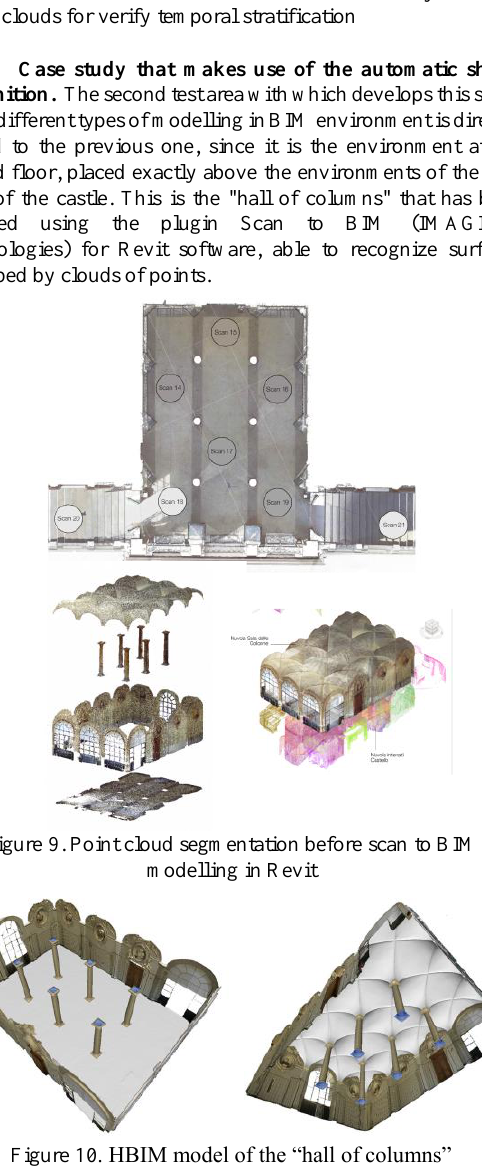
Figure 8. Time information into the model and analysis of the